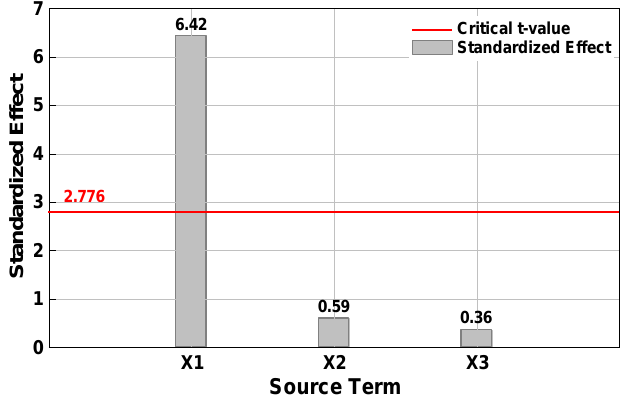
Figure 7. Pareto chart with only main factors.